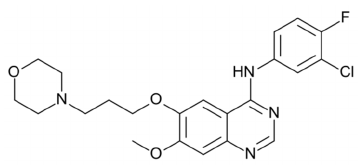
Figure 1. Chemical structure of Gefitinib.